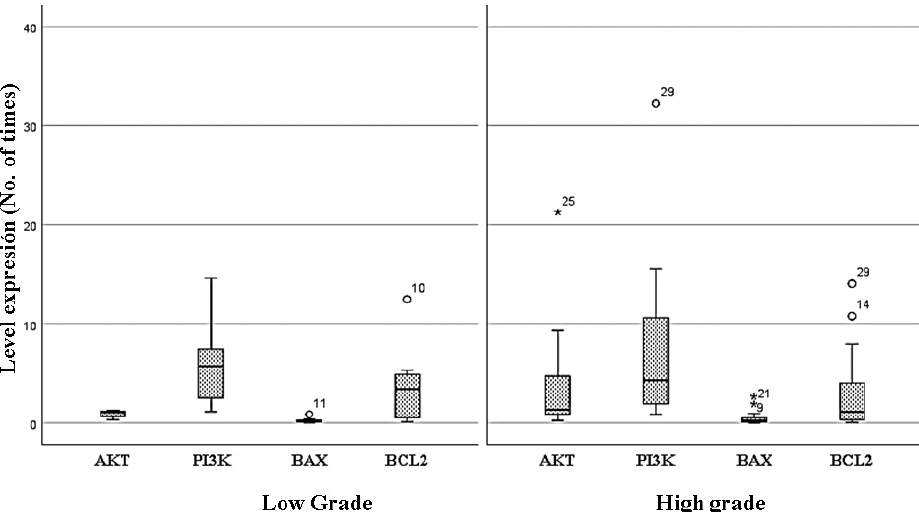
Figure 2. Levels expression in low- and high-grade gliomas. Relative expression levels of AKT, PI3K, BAX, and BCL2 were analyzed by RT-PCR. There was a tendency to increase the expression of AKT in high-grade gliomas, while the expression of PI3K was increased in both low- and high-grade gliomas. Pro-apoptotic BAX showed a low level of expression both in low- and high-grade gliomas, while there is a clear increase in the expression of the anti-apoptotic BCL2 in both glioma grades, however, no statistically significant differences were observed. Asterisks and circles show the samples with the highest level of expression in each group.